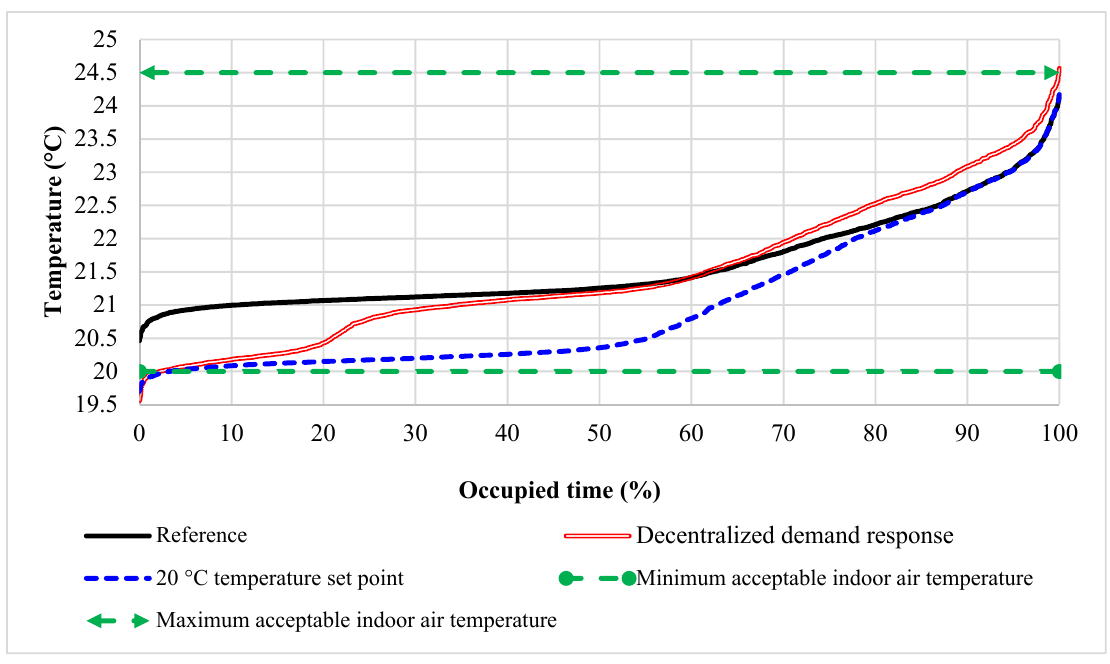
Figure 8. Indoor air temperatures in the coldest room (namely, office room 8 in Figure 4) within the occupied hours (2835 h) with and without DR control.